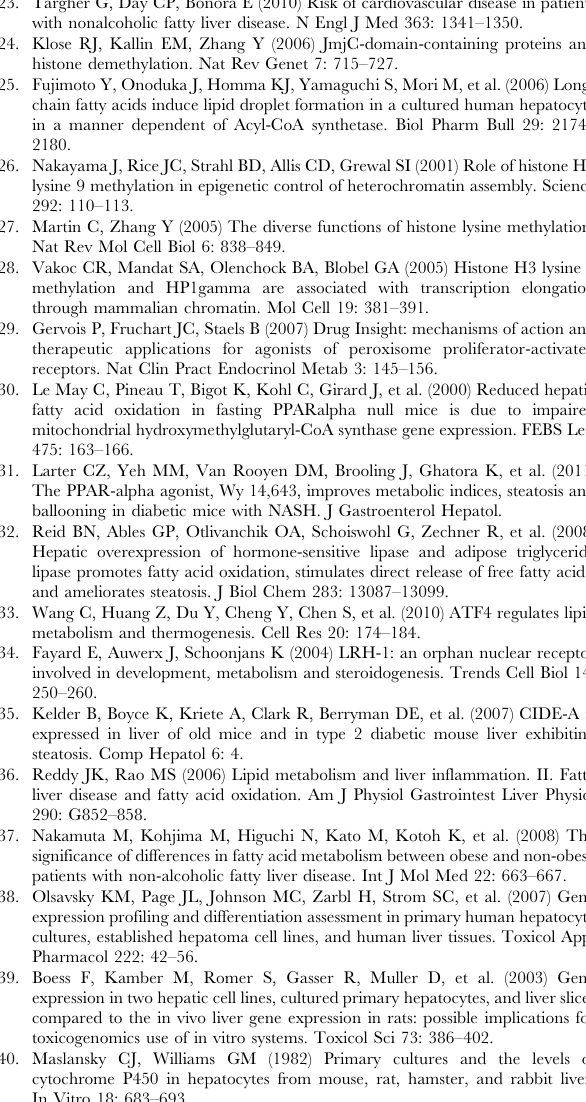
Table S1 Primers used in the conventional ChIP assay, quantitative real-time PCR, and RT-PCR. Table S2 Relative expression of genes encoding epige- netic modifiers in the primary hepatocyte loaded with palmitate and oleate. Table S3 Twenty-two H3K9me3 and H3K4me3 lipid metabolism